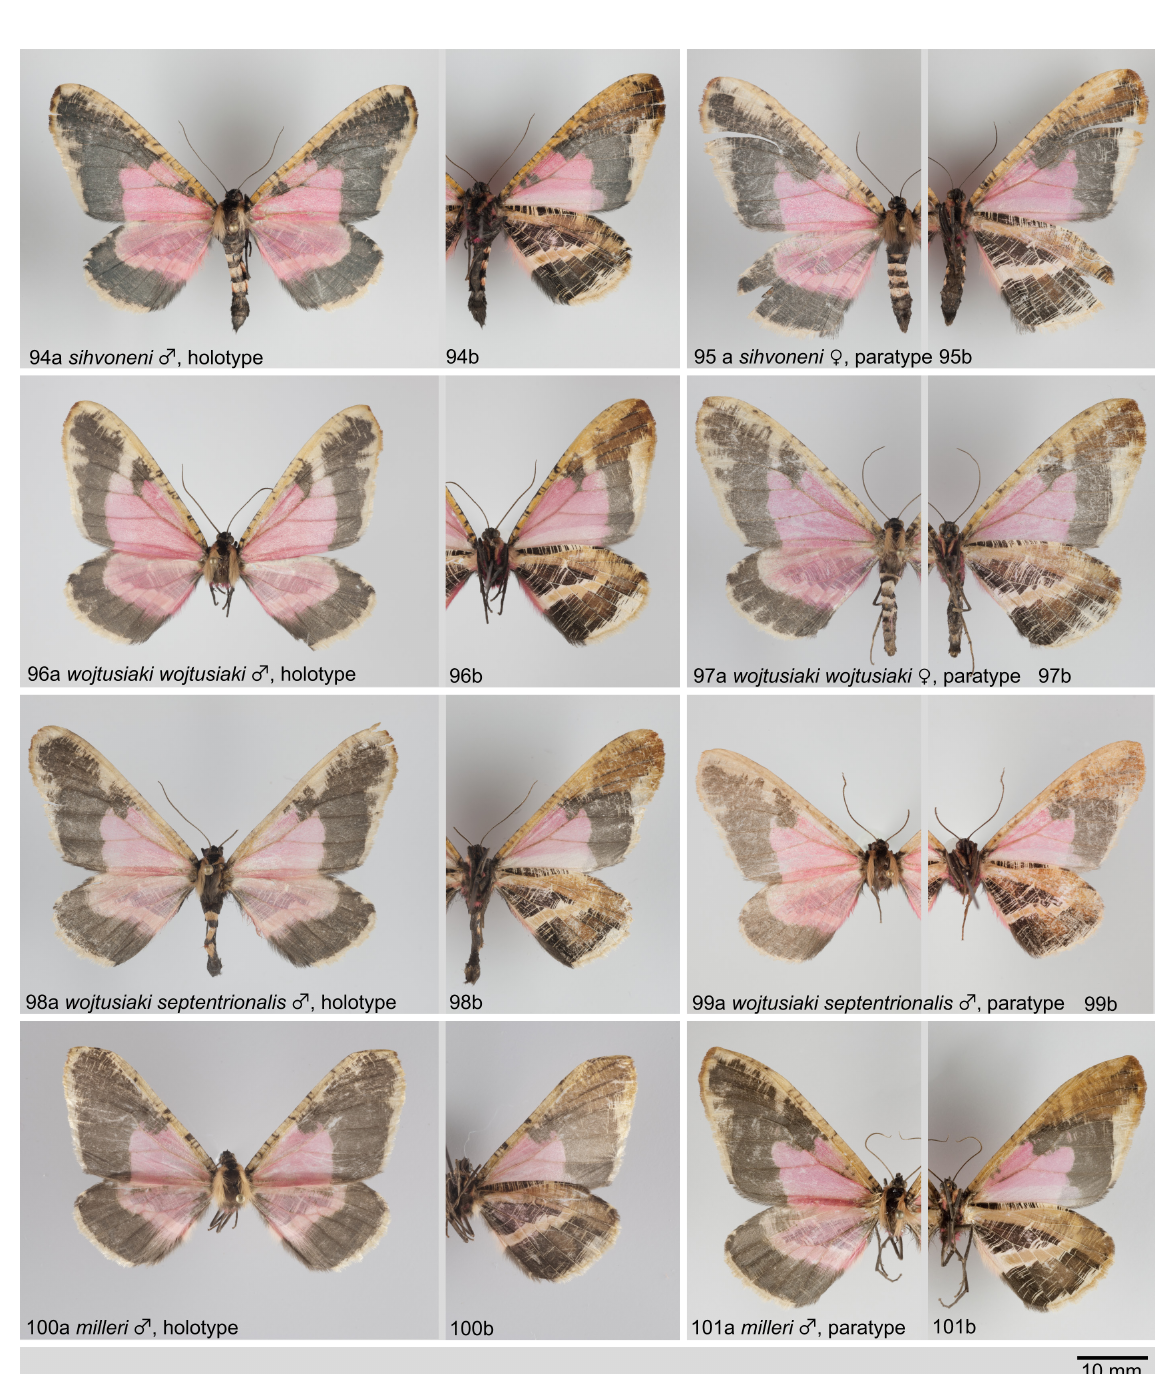
Figs 94–101. Adult moths (a = dorsal view; b = ventral view). 94 . Callipia sihvoneni sp. nov., ♂, holotype (C-0418, COI data). 95 . C. sihvoneni sp. nov., ♀, paratype (C-0396, COI data). 96 . C. wojtusiaki wojtusiaki sp. nov., ♂, holotype (C-0046, COI data). 97 . C. wojtusiaki wojtusiaki sp. nov., ♀, paratype (C-0040, COI data). 98 . C. wojtusiaki septentrionalis subsp. nov., ♂, holotype (C-0012, COI data). 99 . C. wojtusiaki septentrionalis subsp. nov., ♂, paratype (C-0013, COI data). 100 . C. milleri sp. nov., ♂, holotype (C-0370, COI data). 101 . C. milleri sp. nov., ♂, paratype (C-0008, COI